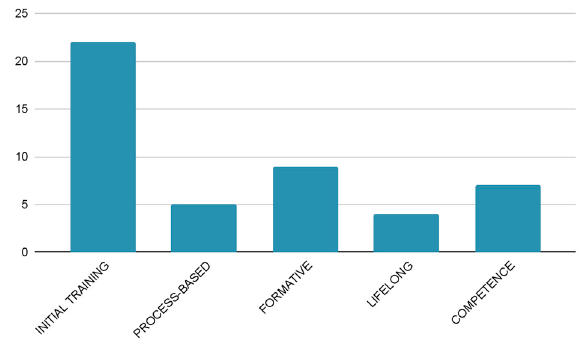
Figure 9. Training of new